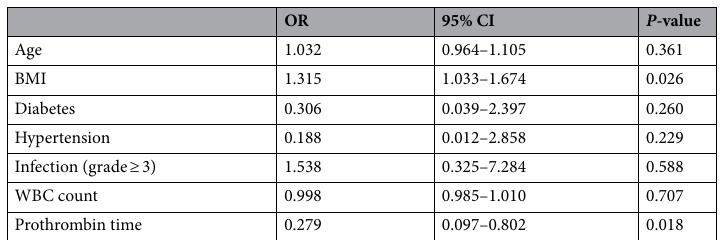
Table 2. Risk Factors associated with PICC-associated venous thromboembolism (multivariate logistic regression analysis). BMI Body mass index, PICC Peripherally inserted central catheter, WBC White blood cell. Variables that had a P -value < 0.10 (age, BMI, diabetes, hypertension, PICC-related infections, WBC) in univariable analysis were selected for inclusion in the multivariable